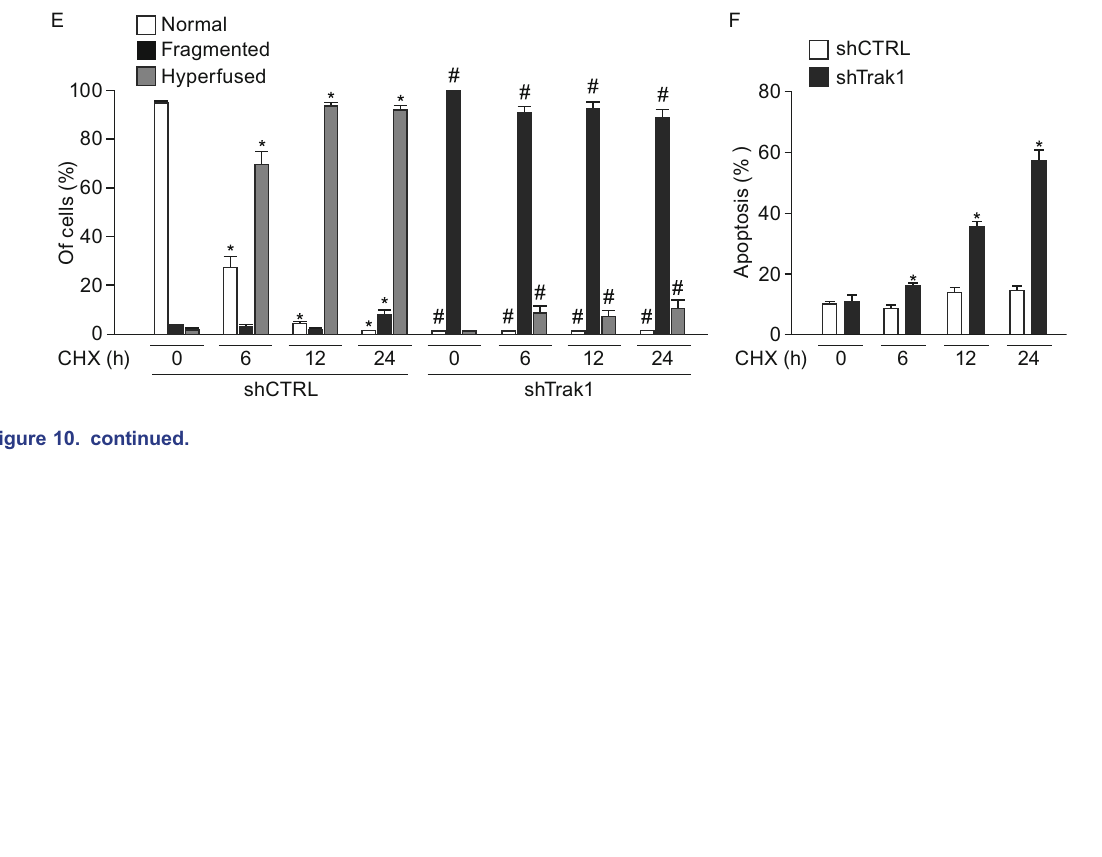
Figure 10. Stress-induced mitochondrial hyperfusion and pro-survival response require Trak1. (A and D) Confocal microscopic analysis of stable shCTRL- and shTrak1-trans- fected HeLa cells after starvation with HBSS (A) or exposure to protein synthesis inhibitor CHX (D) for the indicated lengths of time. Mitochondria were visualized by immunostaining with anti- TOM20 antibody (red), and nuclear integrity was assessed by DAPI staining (blue). Inset shows an enlarged view of the boxed region, and arrowheads indicate apoptotic nuclei. Scale bars: 10 μ m. (B and E) The percentage of cells with indicated mitochondrial morphology was quanti fi ed at the indicated time points after stress exposure and shown as mean ± SEM of three independent experiments. *, P < 0.05 versus the shCTRL- transfected control at 0 h; #, P < 0.05 versus the corresponding shCTRL control at the same time point, one-way analysis of variance with a Tukey ’ s post hoc test. (C and F) Apoptosis was quanti fi ed as the percentage of cells with apoptotic nuclear morphology and shown as mean ± SEM of three independent experiments. *, P < 0.05 versus the shCTRL-transfected control at 0 h, one-way analysis of variance with a Tukey ’ s post hoc